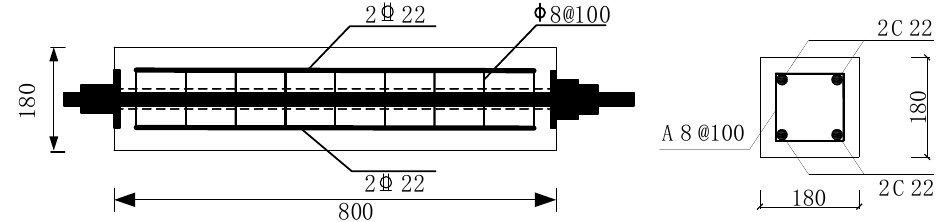
Figure 1. Schematic diagram of reinforcing steel bars for axial compression members (Unit: mm).